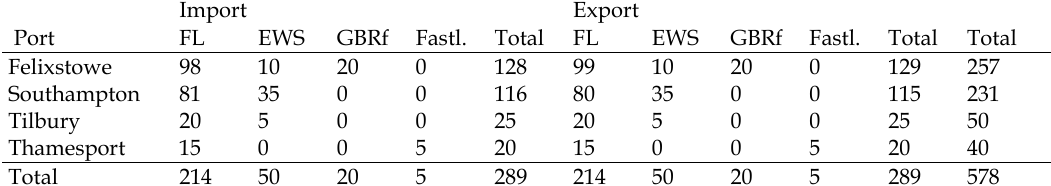
Table 1. Composition of survey sample by port, freight operating company and direction of flow